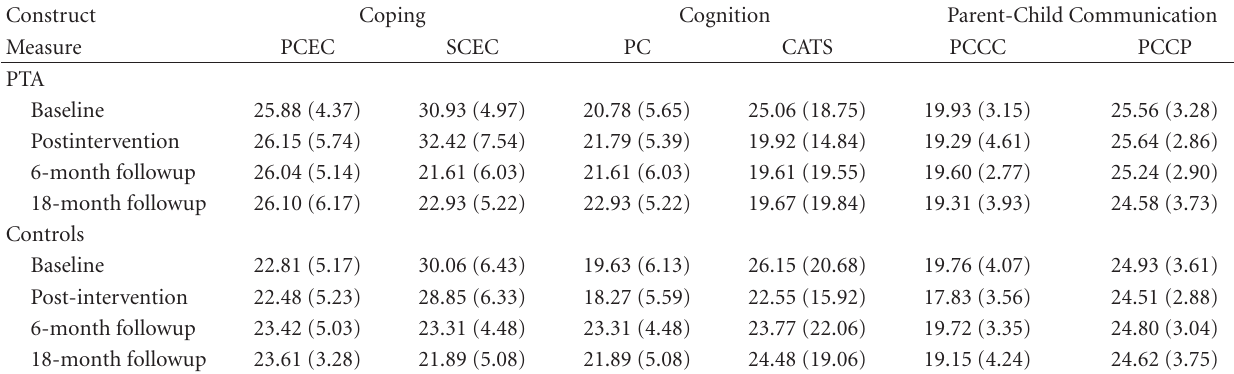
Table 5: Adjusted mean scores on proximal outcome measures by group and